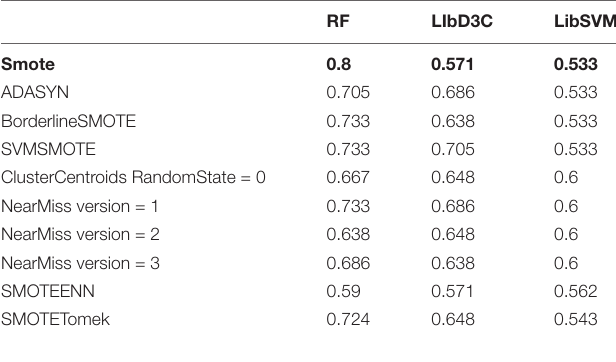
TABLE 2 | The accuracy rate of eight data imbalance processing methods in different classifiers.